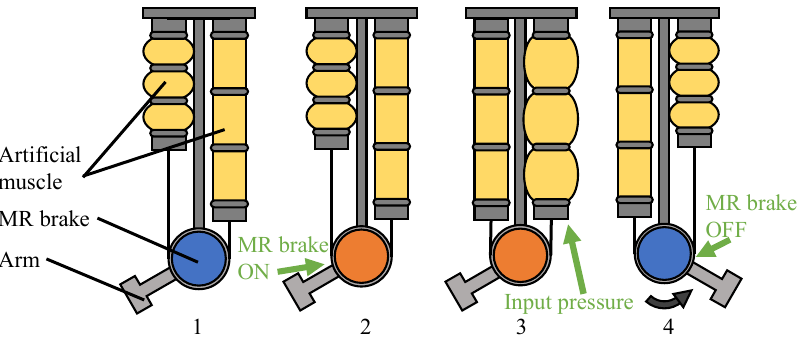
Figure 12. Schematic diagram of instantaneous operation.